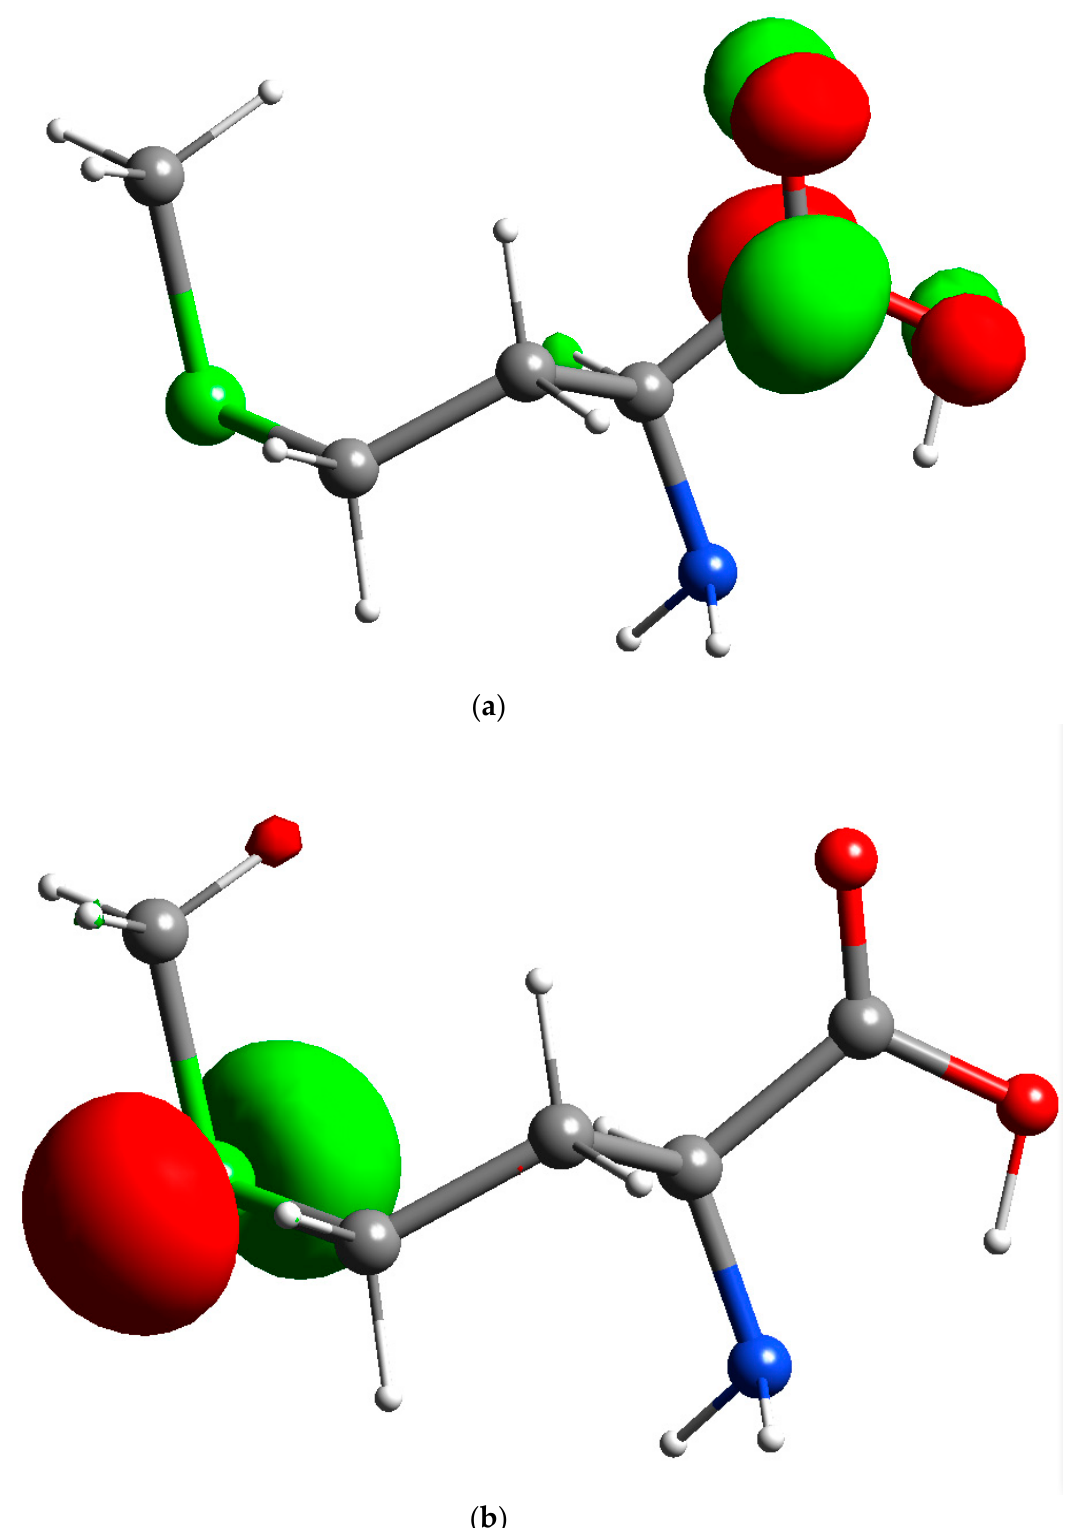
Figure 4. Orbital of methionine: ( a ) Lowest occupied molecular orbital (LUMO) of methionine (isosurface value of 0.09); ( b ) Highest occupied molecular orbital (HOMO) of methionine (isosurface value of 0.09).